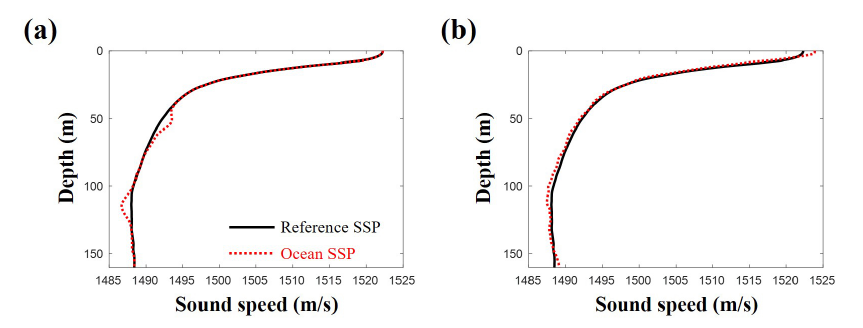
Figure 6. ( a ) sound speed profile generated by the two Gaussian functions and ( b ) sound speed profile generated by the three components of empirical orthogonal functions.